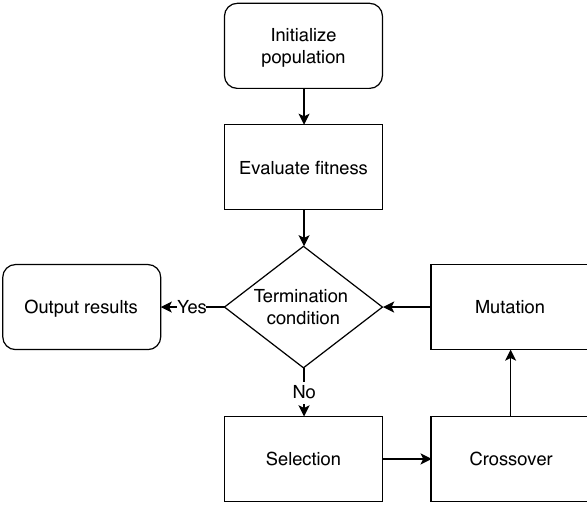
Figure 2. Genetic algorithm flowchart. Population of Members